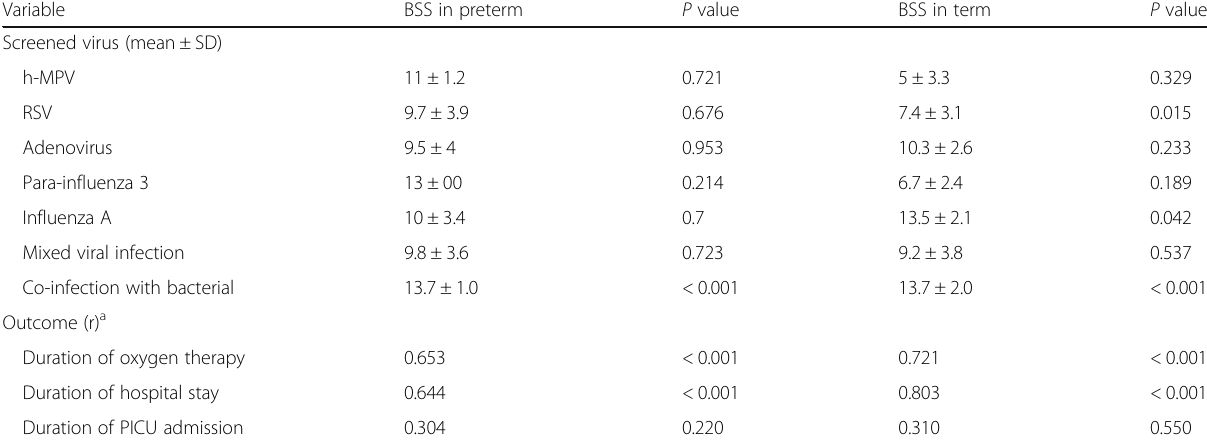
Table 5 Correlating bronchiolitis severity score to screened viruses and outcome in preterm and term infants